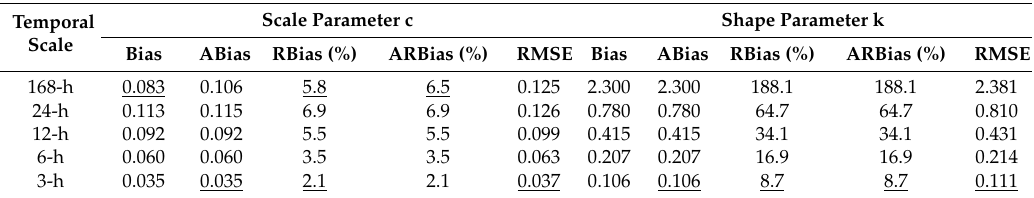
Table 8. Means of the evaluation criteria for the Weibull parameter estimates by the raw wind speed data with different temporal scale based on the parameter estimates of the Weibull distribution for hourly wind speed data at all the stations. Note that the underline indicates that the accuracy of Weibull parameter estimates from the raw data is superior to the Weibull parameter estimates by the downscaling